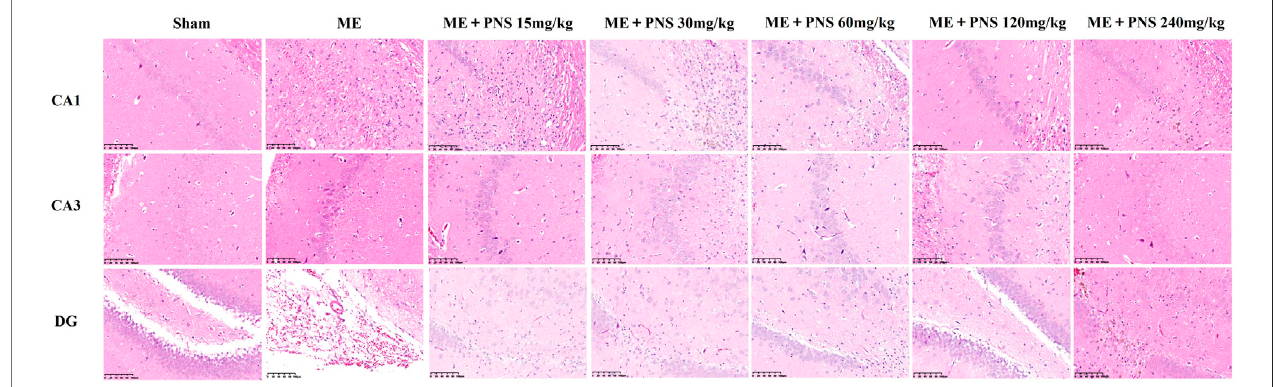
FIGURE 4 | Effect of PNS on histopathological changes of hippocampal CA1, CA3, and DG in ME rats under a ×200 light microscope (scale bar = 100 μ